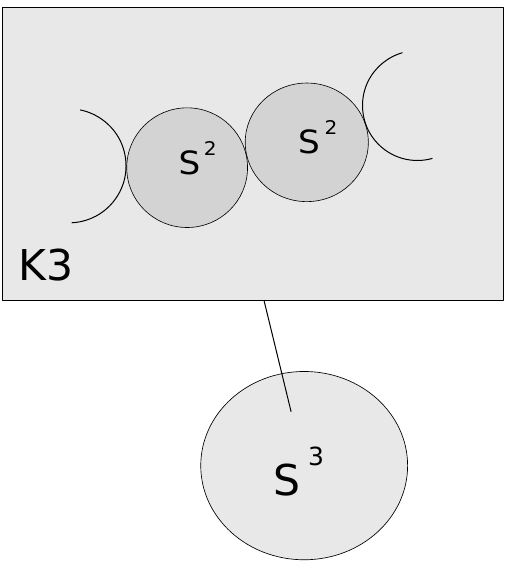
Figure 3 . Local model corresponding to an ADE gauge subsector in IIA compacti(cid:12)cations. In this example, we depict an A 2 singularity that corresponds to an SU(3) gauge